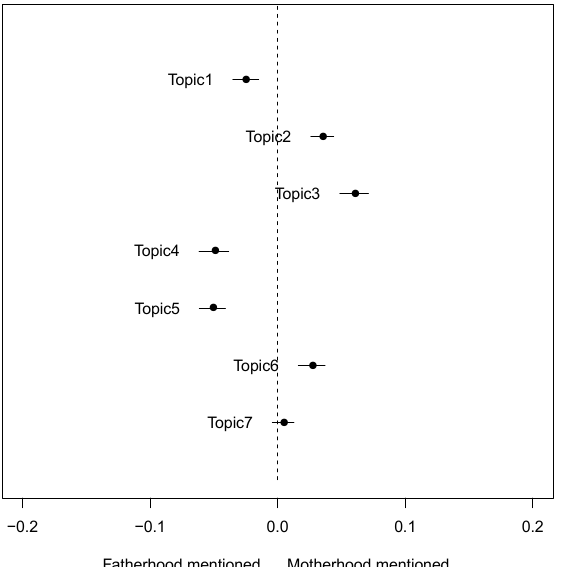
Figure 1. Association between topics and the gender of sex education targets mentioned in the discussions.